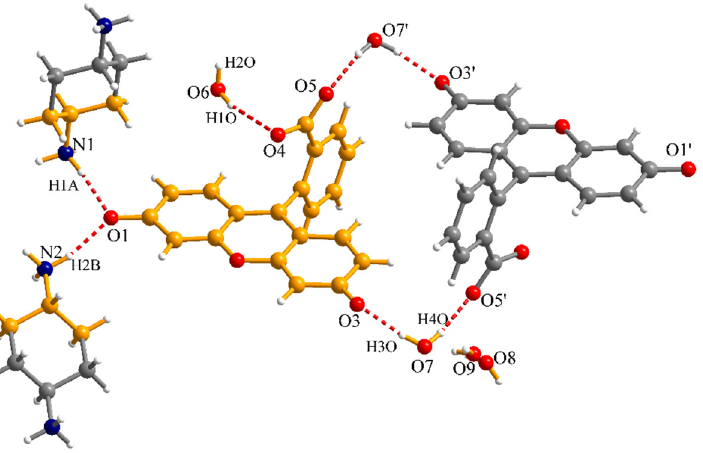
Figure 14. Crystal structure of 8 . The asymmetric unit is depicted in orange. Symmetry code: ’ = 2 − x, 2 − y, 2 − z. x, 2 − y, 2 −